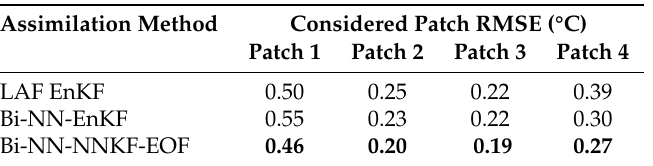
Figure 2. Selected patches on the high resolution component of the SST data. (The SST map corresponds to 19 July 2015). Table 1. Patch-level interpolation experiment: RMSE of the reconstructed anomaly fields for the LAF model ( F P s ) used in an ensemble Kalman filter), Bi-NN-NNKF (Proposed NNKF based on a bilinear residual neural net dynamical mean